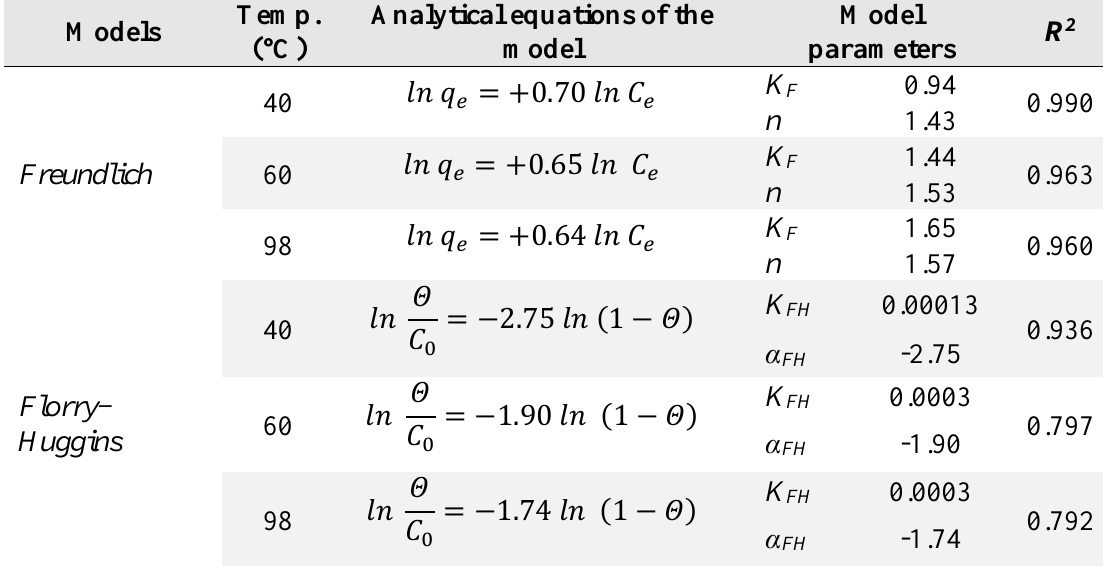
Table 1. Analytical expressions of linear isotherms with coefficients for the reactive dye system